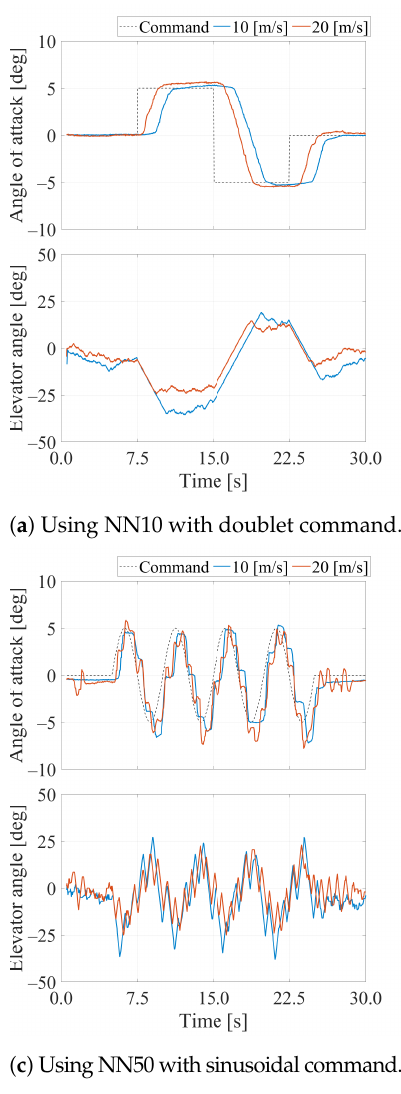
Figure 8. Pitch control results at wind speed of 10 and 20 m/s. NN10 was used to follow doublet ( a ) and sinusoidal ( b ) commands. NN50 was used to follow sinusoidal command ( c